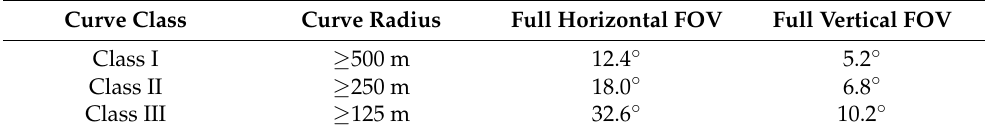
Table 4. The required opening angle for FVCWS function with different curve radii according to [34]. Curve Class Curve Radius Full Horizontal FOV